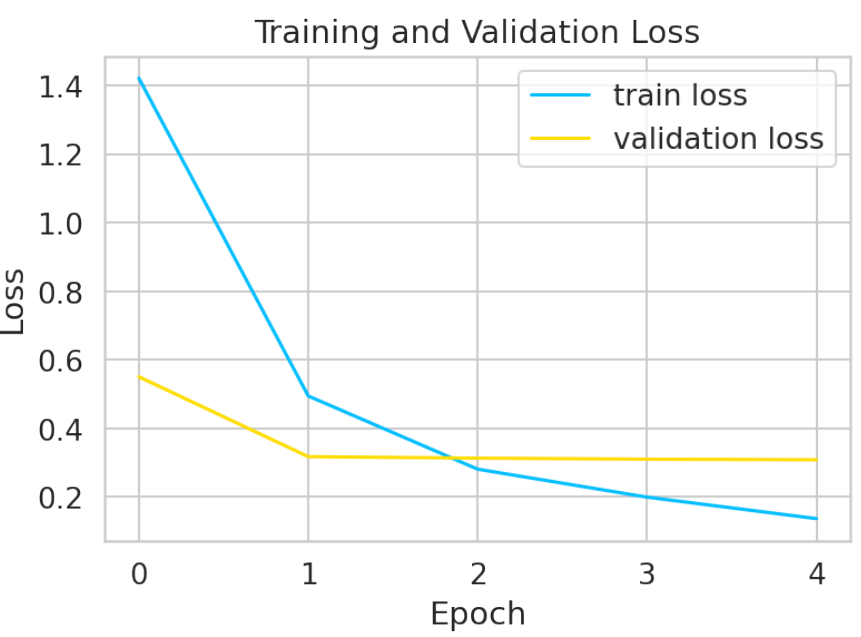
Figure 16. Training and validation loss for